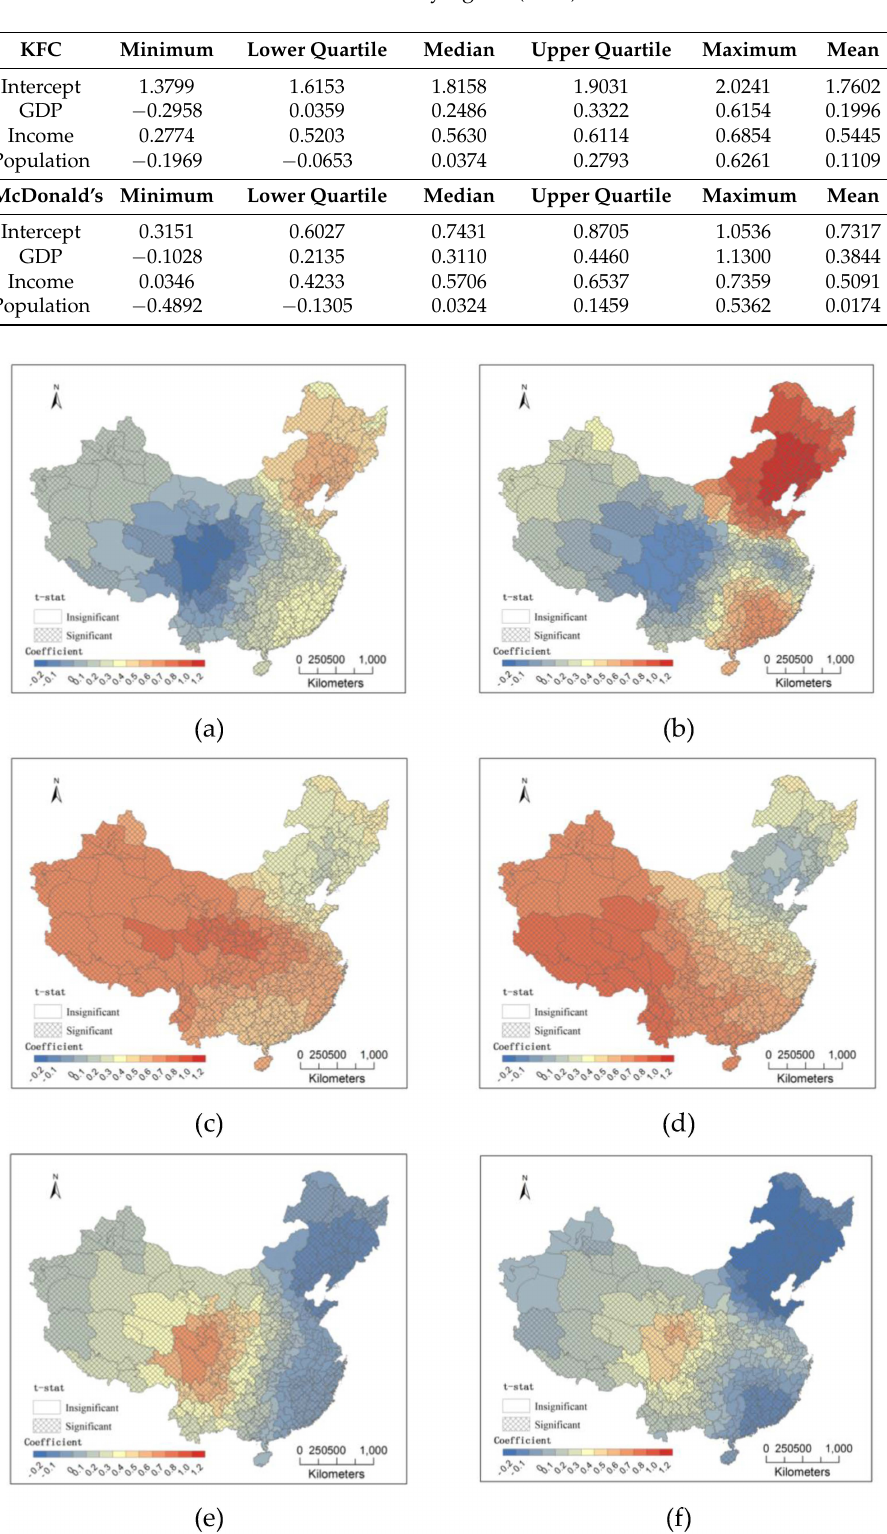
Figure 6. Regression coefficients of G in ( a ) KFC and ( b ) McDonald’s GWPR models; Regression coefficients of I in ( c ) KFC and ( d ) McDonald’s GWPR models; Regression coefficients of P in ( e ) KFC and ( f ) McDonald’s GWPR